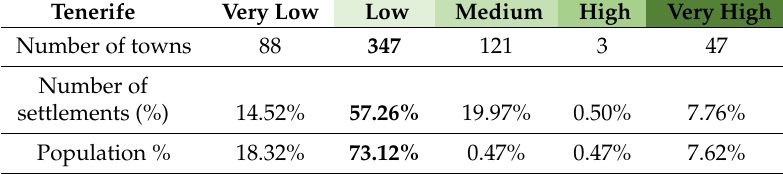
Table 3. Outcomes regarding the accessibility levels in the Island of Tenerife (Source: authors).